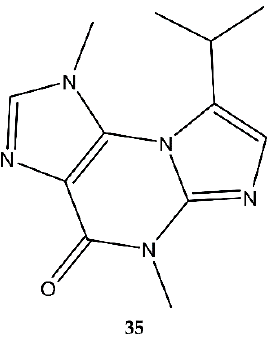
Figure 8. Acremolin B ( 35 ).